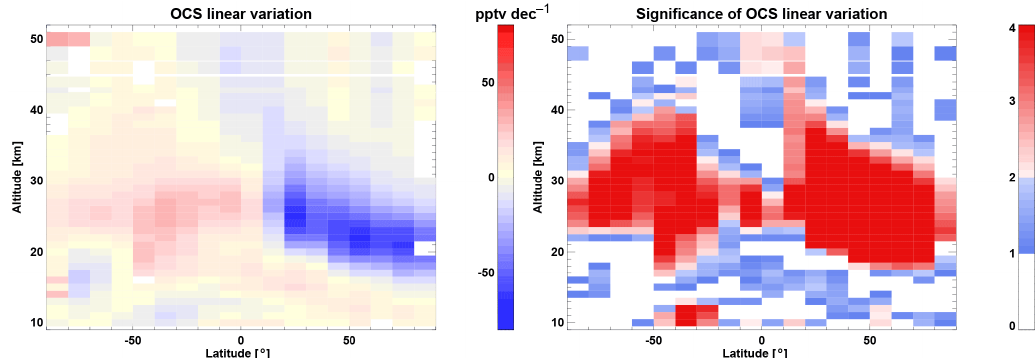
Figure 14. Left: decennial linear trend of monthly averaged OCS volume mixing ratios in 10 ◦ × 1km latitude–altitude bins for the period 2002–2012. Right: significance of the bin-wise trends, estimated by division by the standard deviation from the respective regression